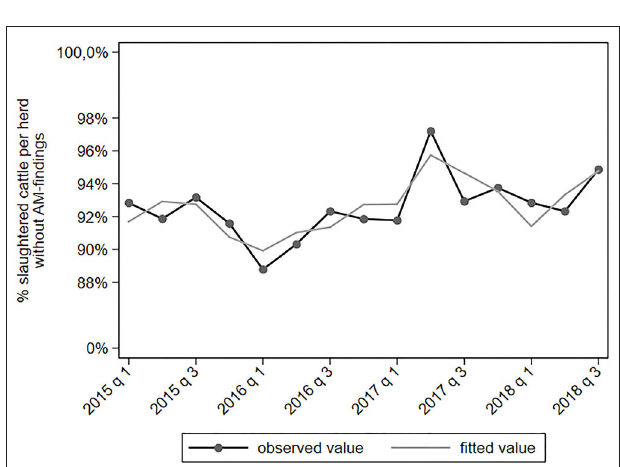
FIGURE 3 | Observed and predicted percentage of slaughtered cattle per dairy herd without AM-findings, per quarter between January 2015 to September 2018 ( N =